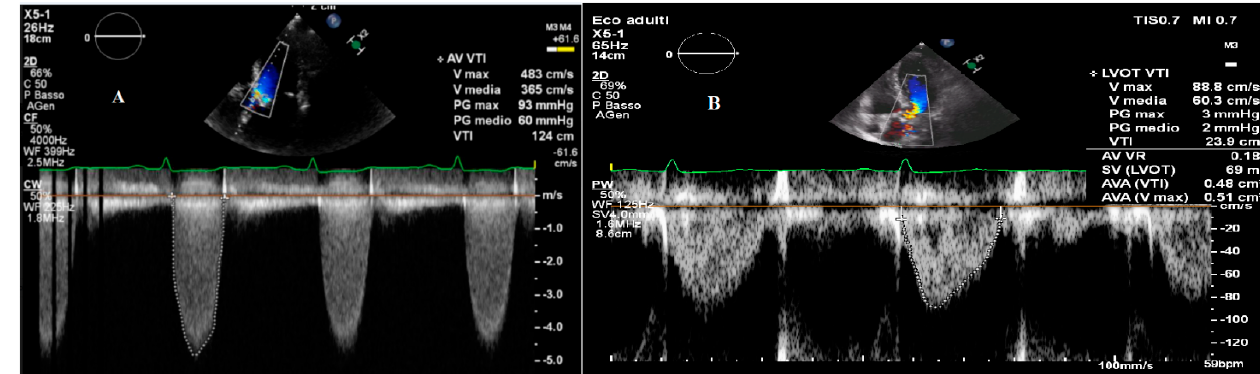
Figure 1. ( A ) : Recording of the peak velocity through a stenotic aortic valve in the apical five ‐ chamber view by continuous ‐ wave Doppler. ( B ): Recording of the peak velocity through Left ventricular outflow tract in the apical three ‐ chamber view by pulse ‐ wave Doppler. The images were executed with Philips EPIQ 7 (Philips Medical System, Bothell, WA, USA).